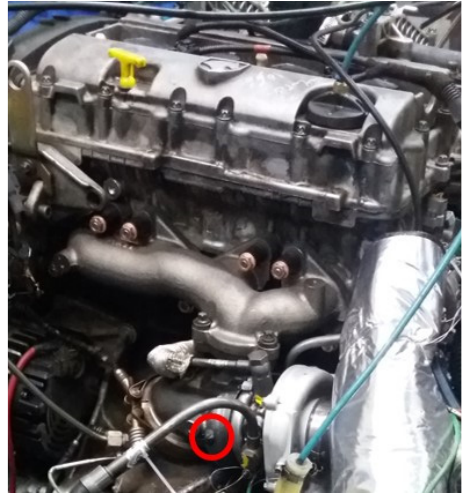
Figure 5. Location of a thermocouple on the turbocharger housing.